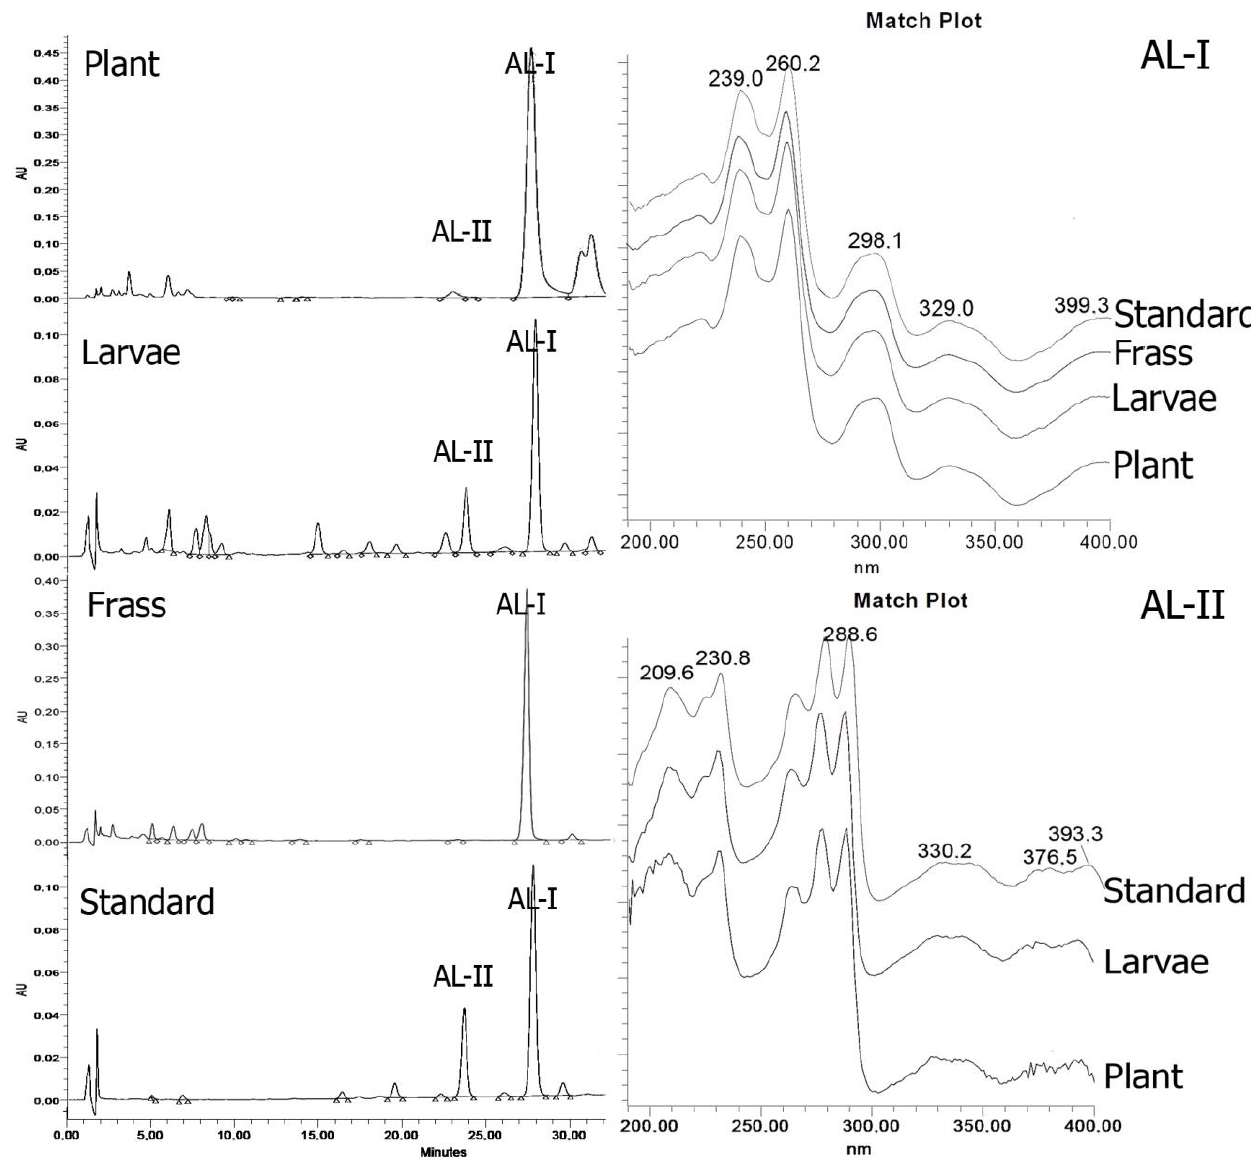
Figure 2. Representative high-performance liquid chromatography with diode-array detection (HPLC-DAD) of the aristolactam (AL) fractions from A . chilensis leaves and stems, fifth instar larvae of B . polydamas archidamas , frass and a standard mixture of AL-I and AL-II.